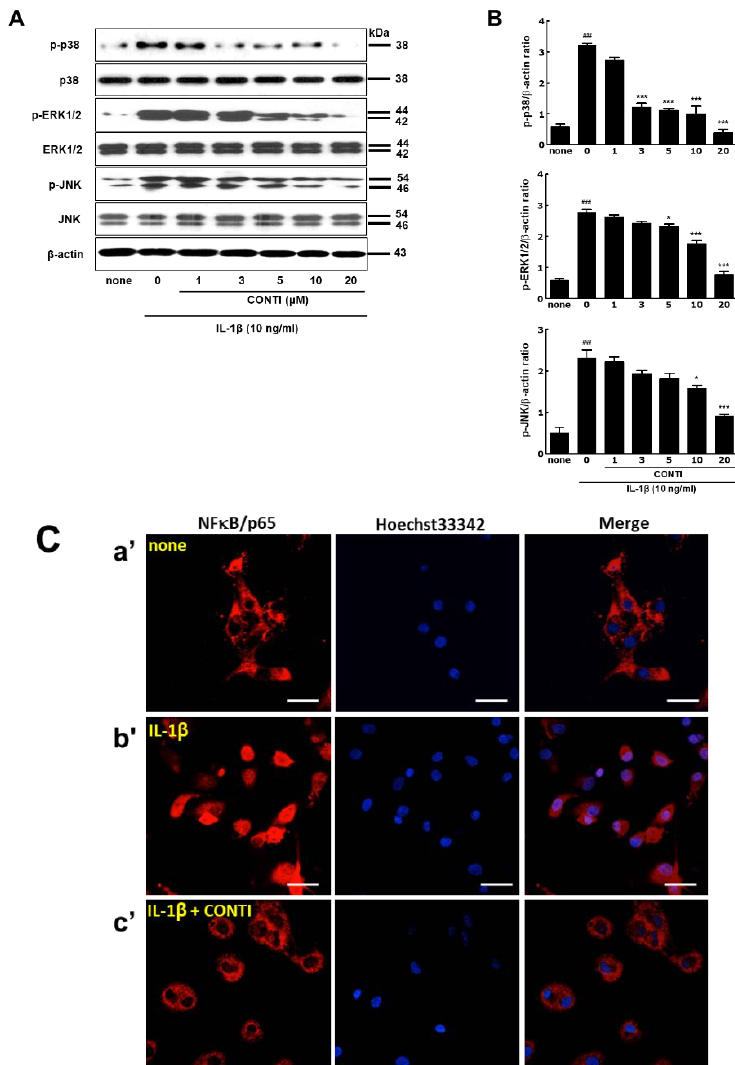
Figure 4. Western blot images ( A ) of p -p38, p -ERK and p -JNK MAP kinases, their bar graphs ( B ), and immunofluorescence image ( C ) of the nuclear translocation of NF- κ B (p65) in IL-1 β -stimulated human OA chondrocytes with the continentalic acid treatment. In Figure C, a’, b’ and c’ indicate non-treated naïve cells (none), IL-1 β (10 ng / mL)-treated cells for 30 min (IL-1 β ), and IL-1 β + CONTI (10 µ M)-treated cells for 1 h (IL-1 β + CONTI), respectively. ERK, extracellular signal-regulated kinase; p-ERK, phosphorylated ERK; JNK, jun N-terminal kinase. CONTI, continentalic acid. NF, nuclear factor. Original magnification: × 400 and scale bar: 40 µ m. ### p < 0.001 vs. non-treated group (none); * p < 0.01 and *** p < 0.001 vs. IL-1 β -treated group without